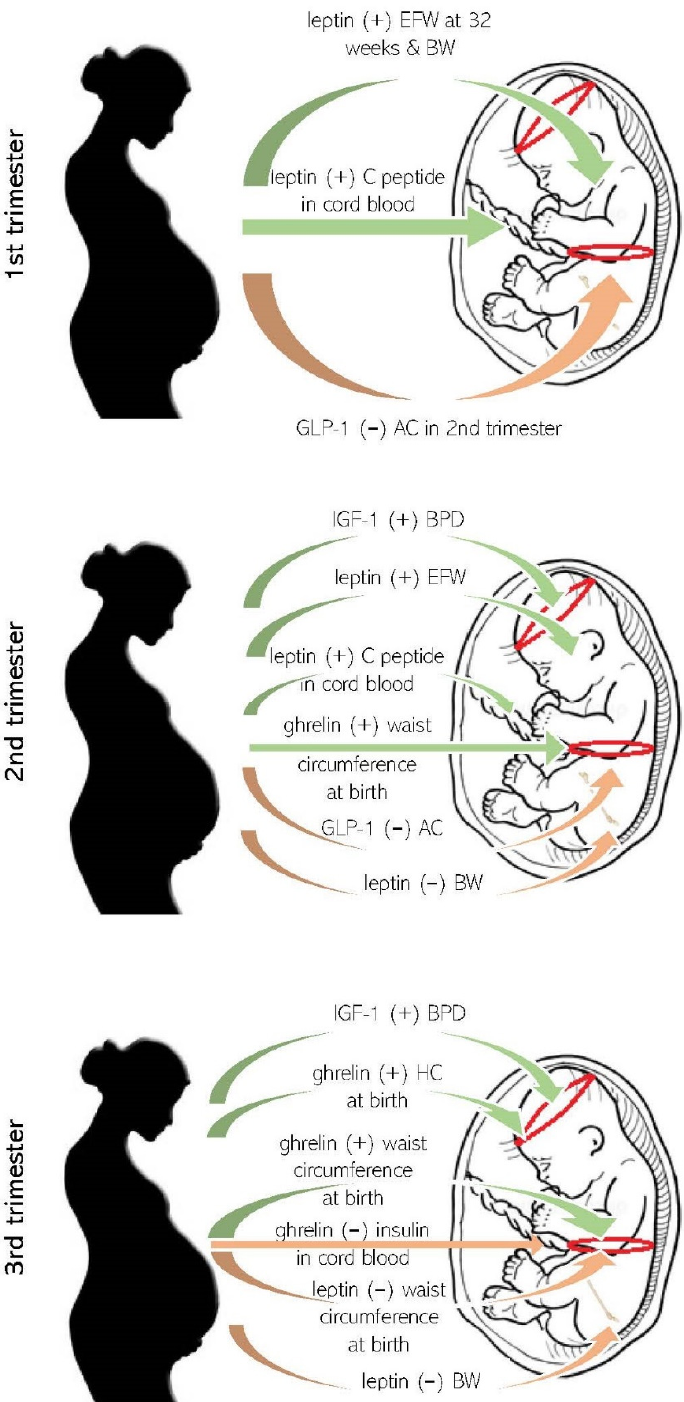
Figure 2. Schematic representation of important study results correlating maternal appetite-regulating molecules with fetal and neonatal growth and metabolic indices, in all three trimesters of human pregnancy. (+): positive correlation, ( − ): negative correlation, EFW: estimated fetal weight, AC: ultrasound estimated abdominal circumference, BPD: biparietal diameter, BW: birth weight.